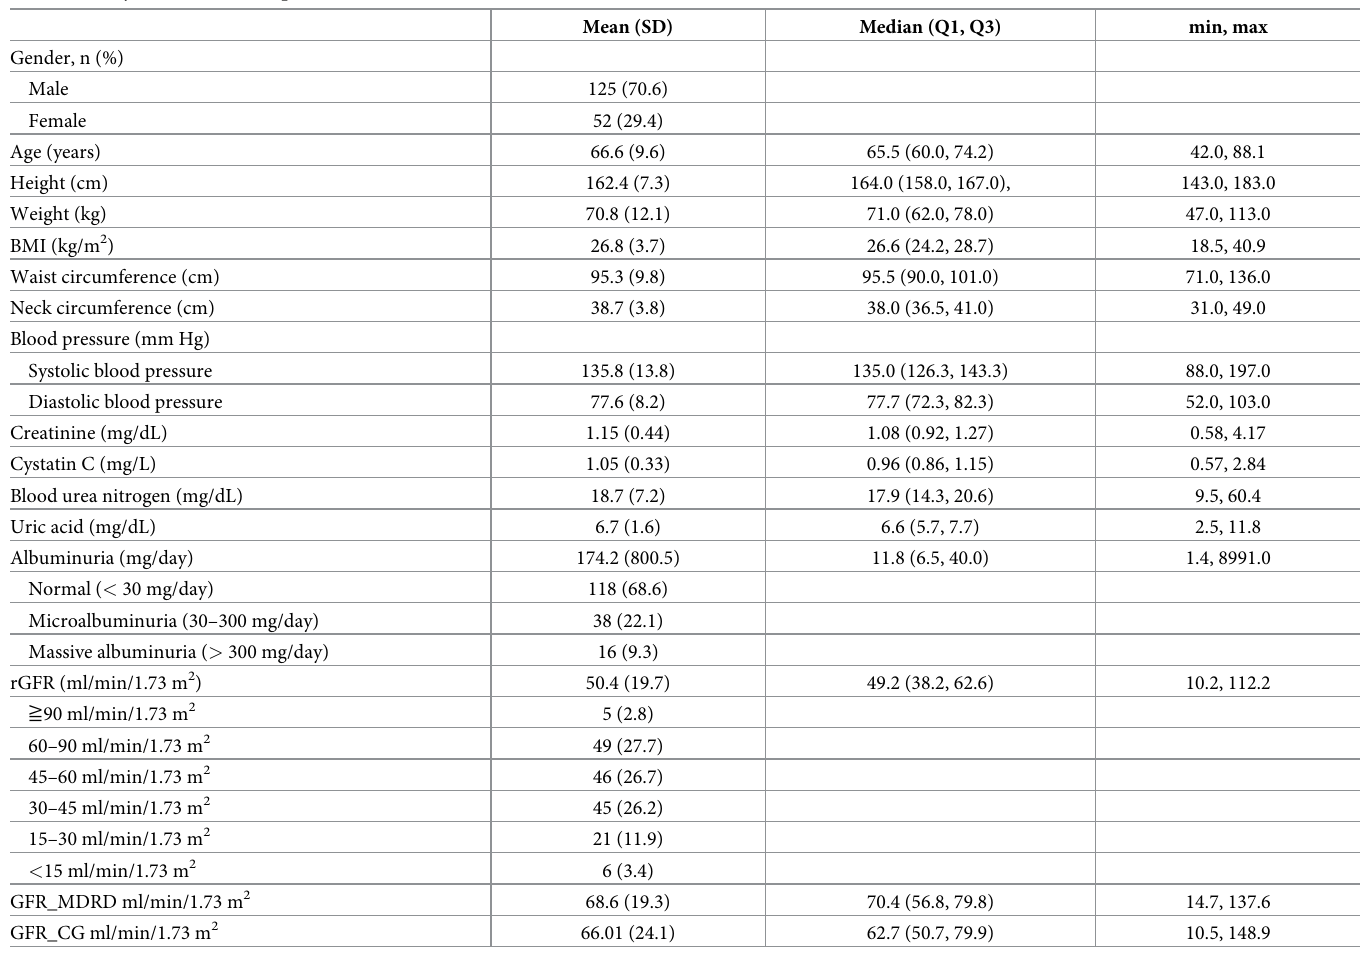
Table 1. Study characteristics of